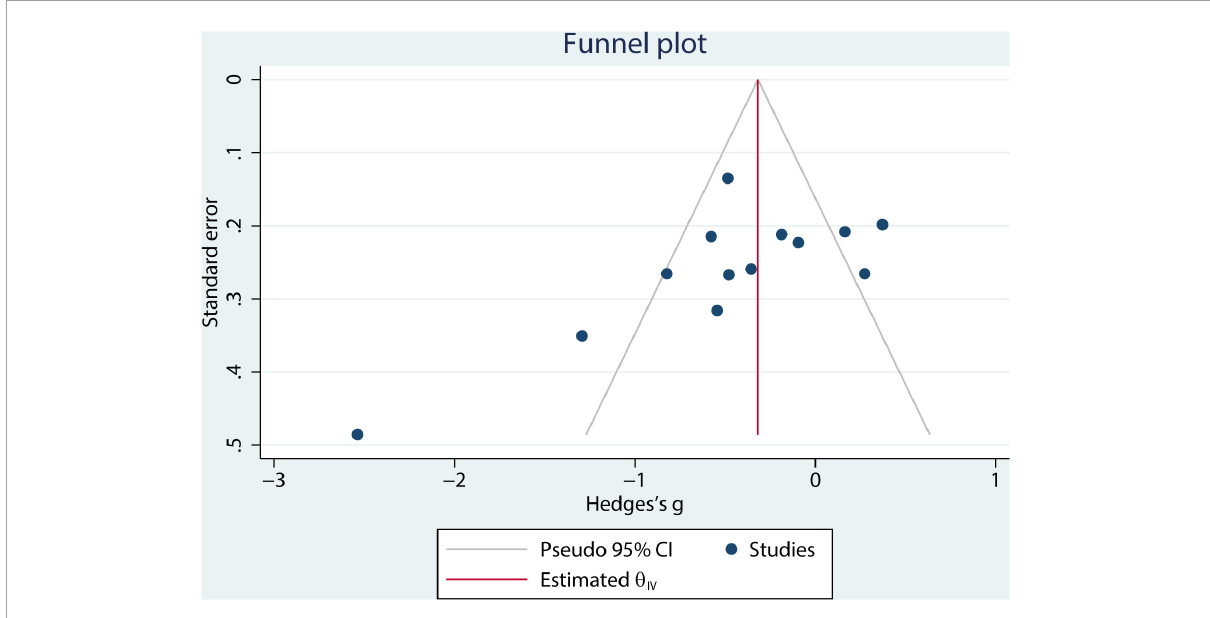
FIGURE9 Funnel plot for overall